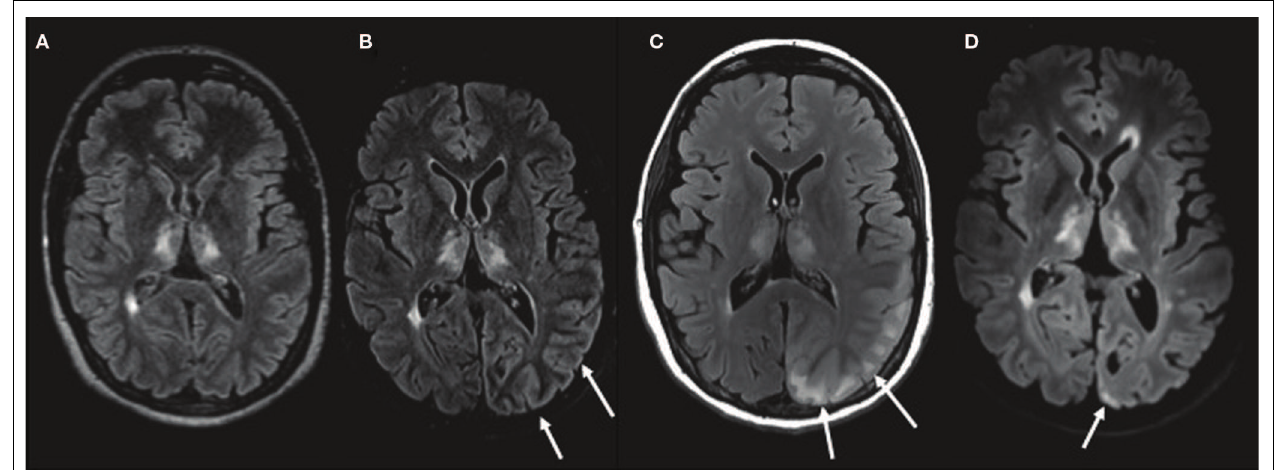
vasogenic edema (arrows; 2D FLAIR 3T). (D) Follow-up MRI May 2014 with small superficial residual changes (arrow) in part of the cortex (3D FLAIR 3T). Chronic neuroinflammatory lesions are seen in the thalami and periventricular white